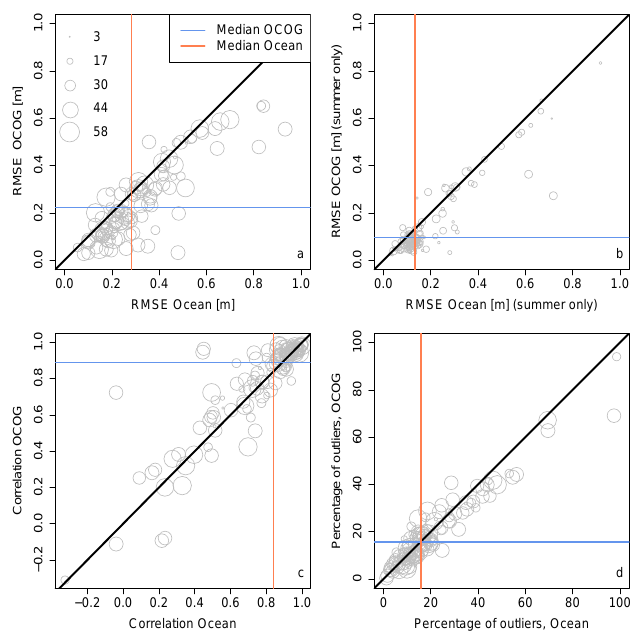
Figure 3. Scatter plot of ( a ) RMSE values, ( c ) Pearson correlation, and ( d ) percentage of outliers for the Canadian lakes. The vertical orange and blue lines represent the median RMSE values for the Ocean and OCOG retrackers, respectively. The size of the circles indicates the number of cycles used in the calculation of the summary measures. To allow a greater detail, only RMSE values below 1 m are shown. Subplot ( b ) shows the RMSE values based on summer data only.